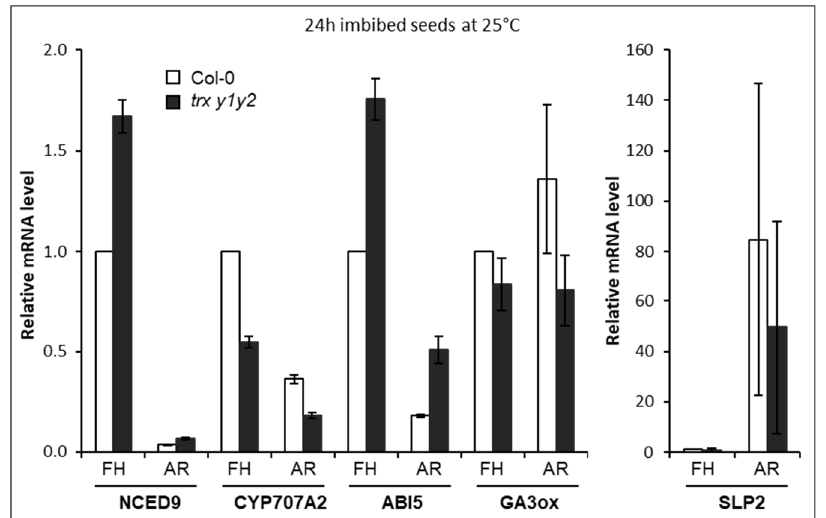
Figure 4. Expression of ABA and GA metabolism-related genes in trx y1y2 mutant seeds. Transcript abundance of AtNCED9 (encoding a 9- cis -epoxycarotenoid dioxygenase involved in ABA synthesis [57]), AtCYP707A2 (encoding an 8 ′ hydroxylase involved in ABA catabolism [58]), AtABI5 (encoding a transcription factor involved in ABA signaling [59]), AtGA3ox (encoding a gibberellin 3-beta-hydroxylase catalyzing the final step of the biosynthetic pathway of GAs [60]), and AtSLP2 (encoding a shewanella-like protein phosphatase, implicated in GA signaling [9]) was examined using RT-QPCR in freshly harvested (FH), or 7-week after-ripened (AR) seeds imbibed for 24 h in the dark at 25 °C. Transcript levels were normalized to the expression of At4g12590 seed constitutive gene and an arbitrary unit was assigned to the expression level in the Col-0 (FH) sample for each gene. Means ± SD from duplicate experiments.